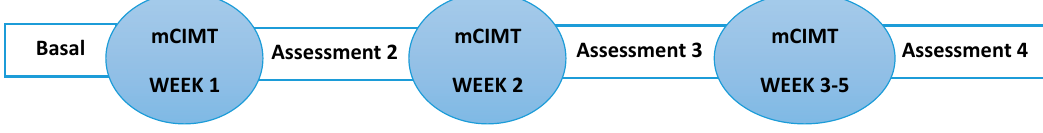
Figure 3. Representation of the assessment number in the 5 weeks of treatment (mCIMT).